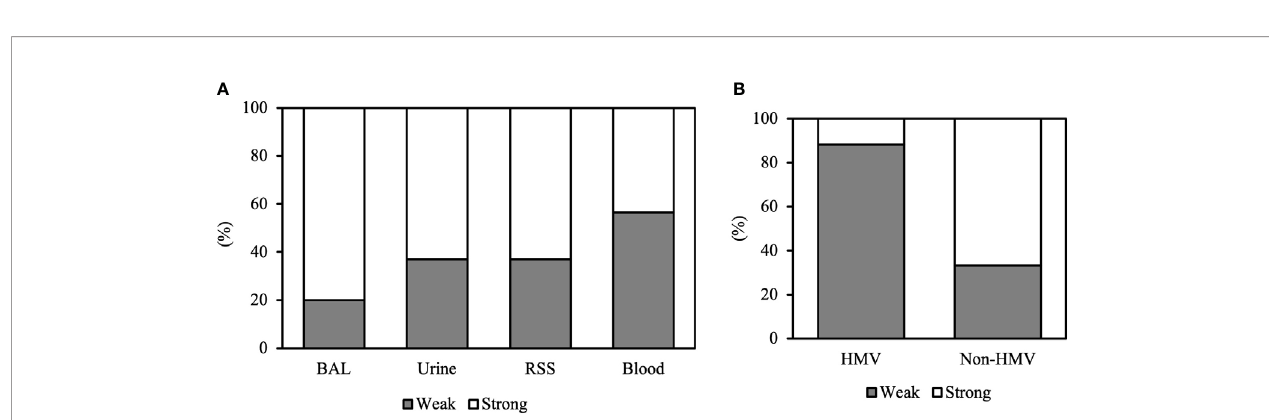
FIGURE 1 | String test for identi fi cation of the HMV phenotype. A positive string test (A) is de fi ned as the formation of viscous strings of >5 mm in length on an agar plate. (B) Sedimentation assay for HMV and non-HMV isolates.